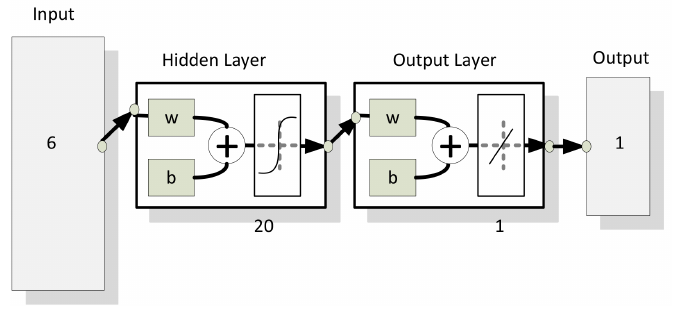
Figure 5. Neural network diagram used to obtain